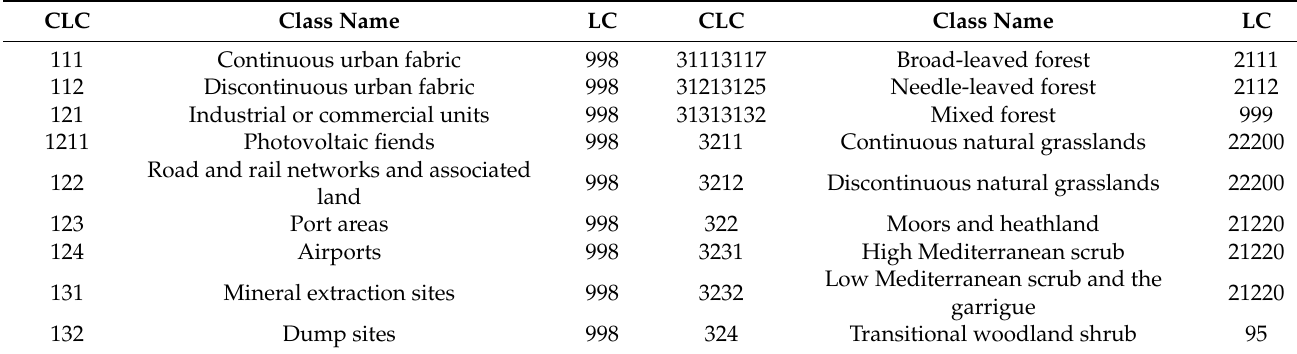
Table A4. Reclassification table for